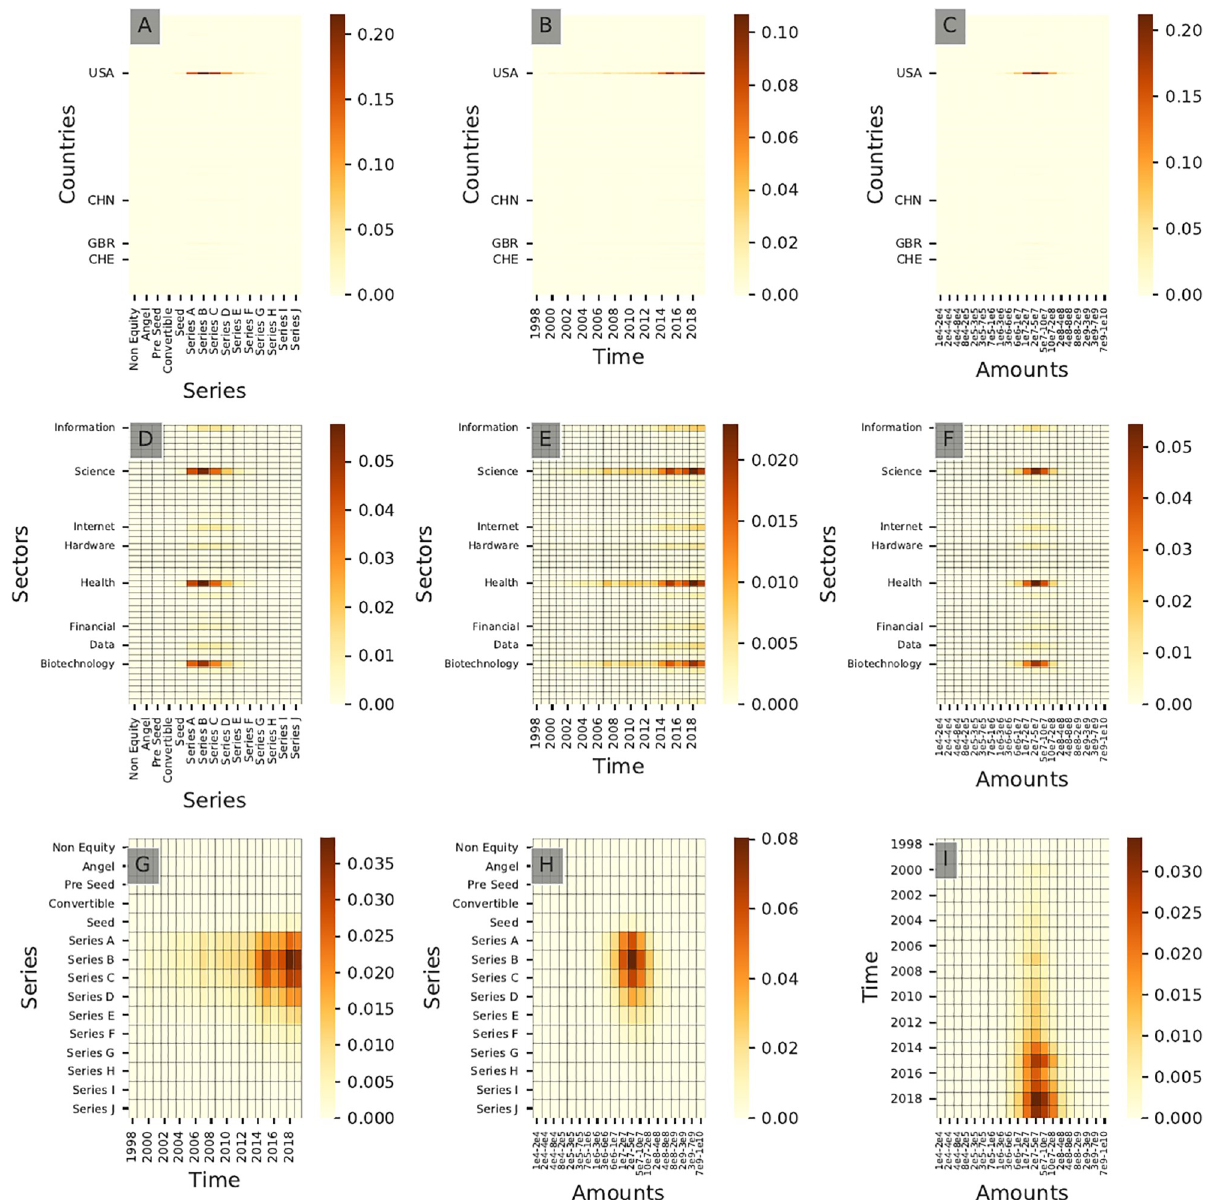
Fig 13. Cross-interaction heatmaps for community C7. This community corresponds to a Health Care-focused community of investors. Only the top 8 sectors in terms of total number of investments and the top 4 countries of investment are labeled for readability purposes.